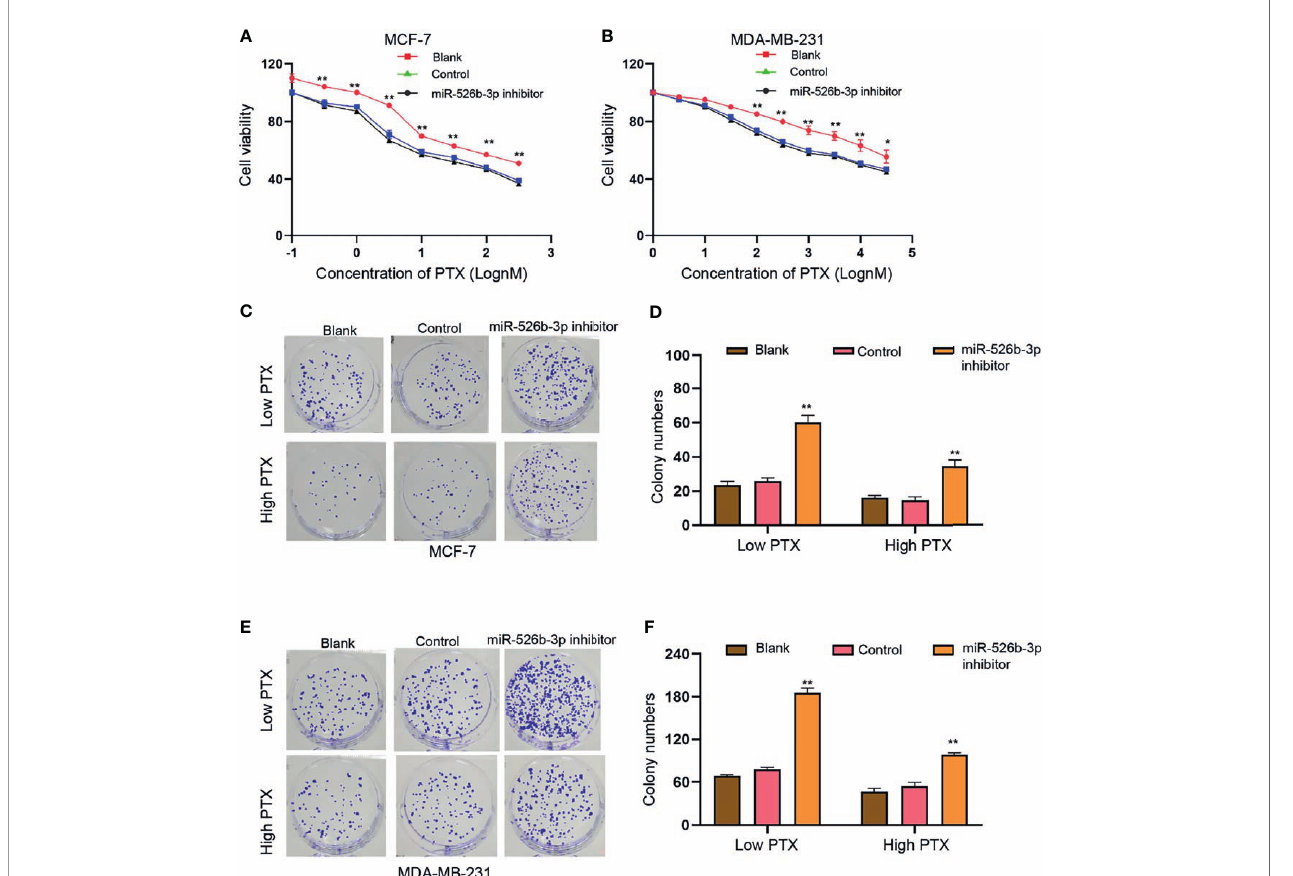
FIGURE 4 | MiR-526b-3p represses PTX resistance of breast cancer cells. (A – F) MCF-7 and MDA-MB-231 cells were treated with different concentration of PTX and were co-treated with miR-526b-3p inhibitor. (A, B) Viability of MCF-7 and MDA-MB-231 cells was detected by CCK-8 analysis. (C – F) MCF-7 and MDA-MB-231 cells were treated with low dose (3 nM) or high dose (100 nM) of PTX and were cotransfected with miR-526b-3p inhibitor. Proliferation of MCF-7 and MDA-MB-231 cells was detected by colony formation assays. Data are mean ± SD: * p < 0.05, ** p <